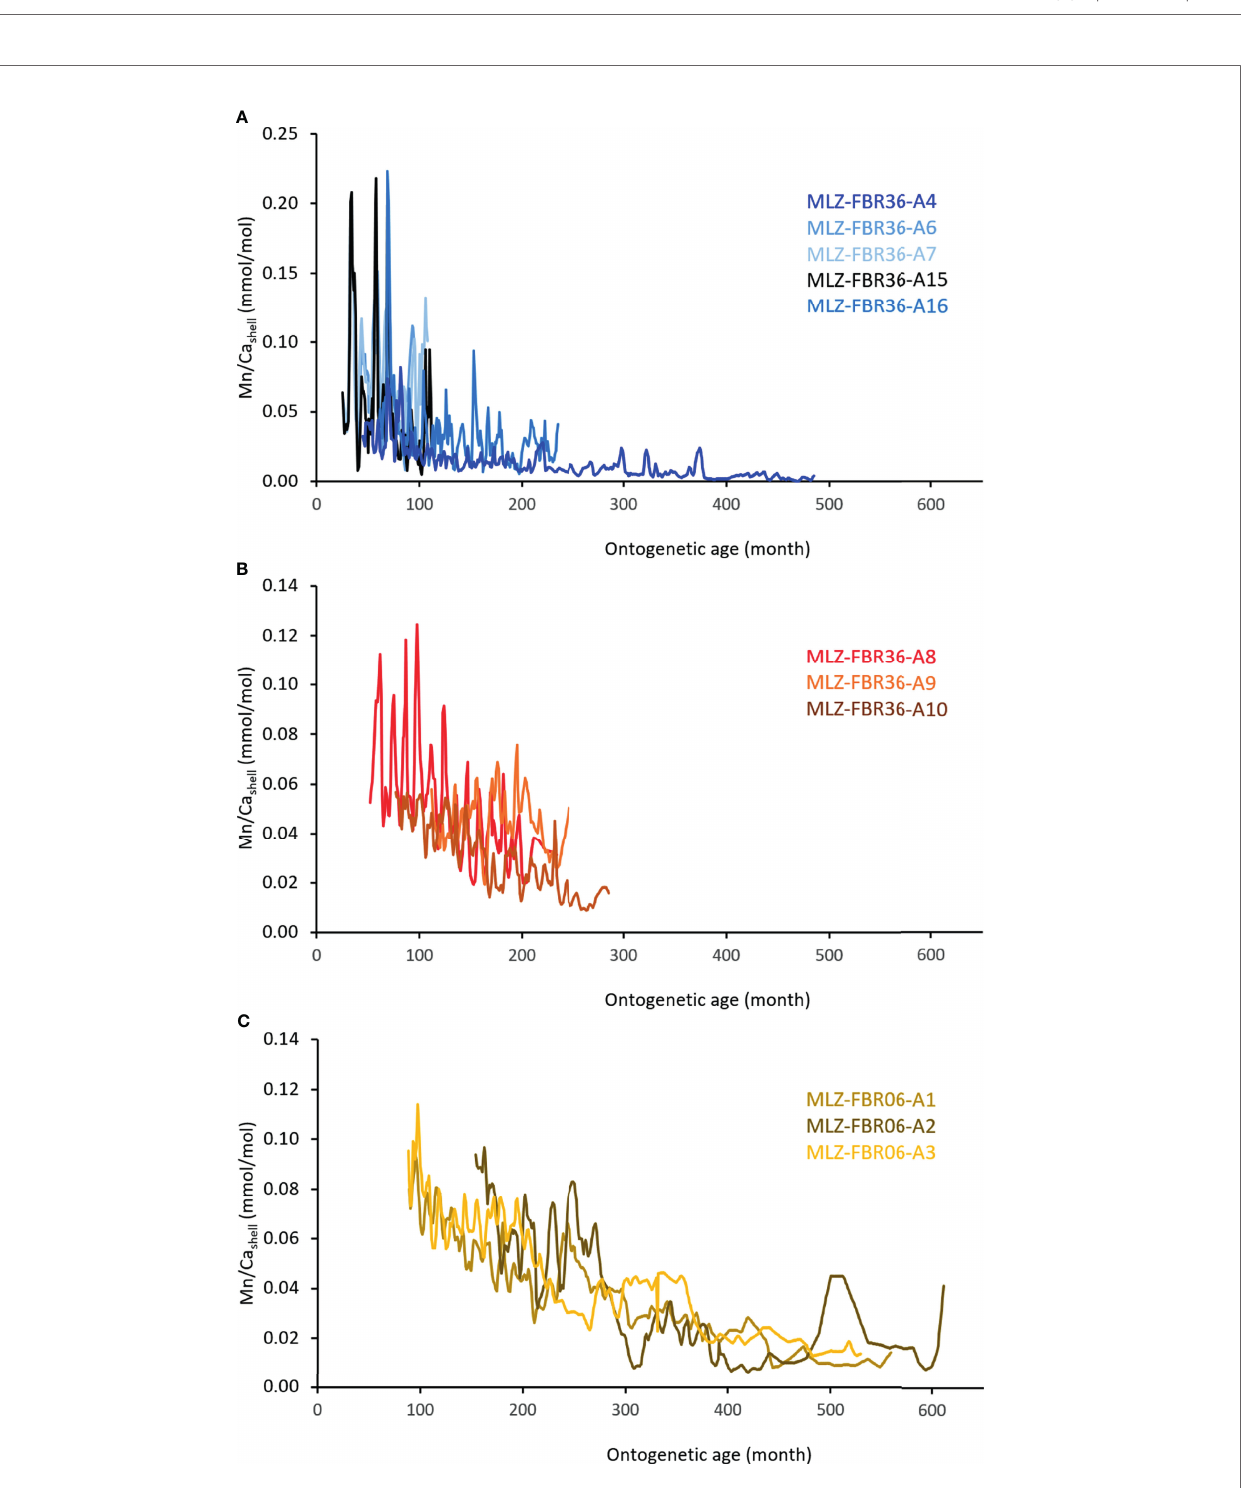
FIGURE 5 | Mn/Ca shell chronologies (monthly resolution) reveal striking ontogenetic trends to lower values. (A) A. islandica ; (B) A. elliptica ; (C) A. borealis